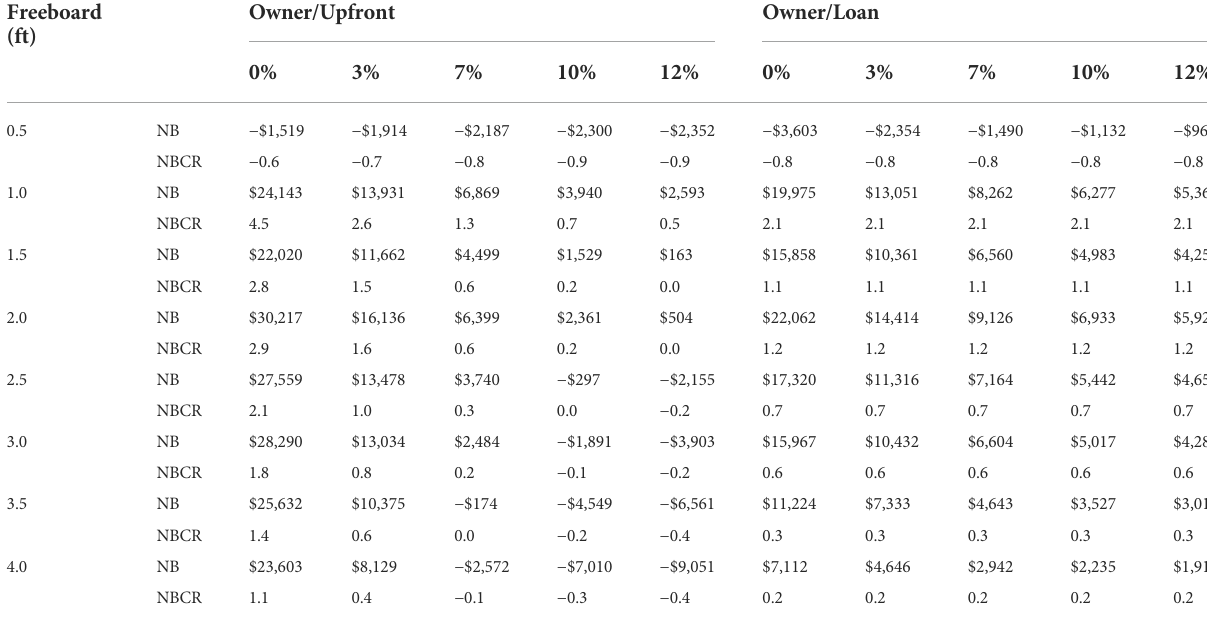
TABLE 7 Apportioned net bene fi t (NB) and net bene fi t-cost ratio (NBCR) by freeboard scenario and discount rate: Owner share. Freeboard